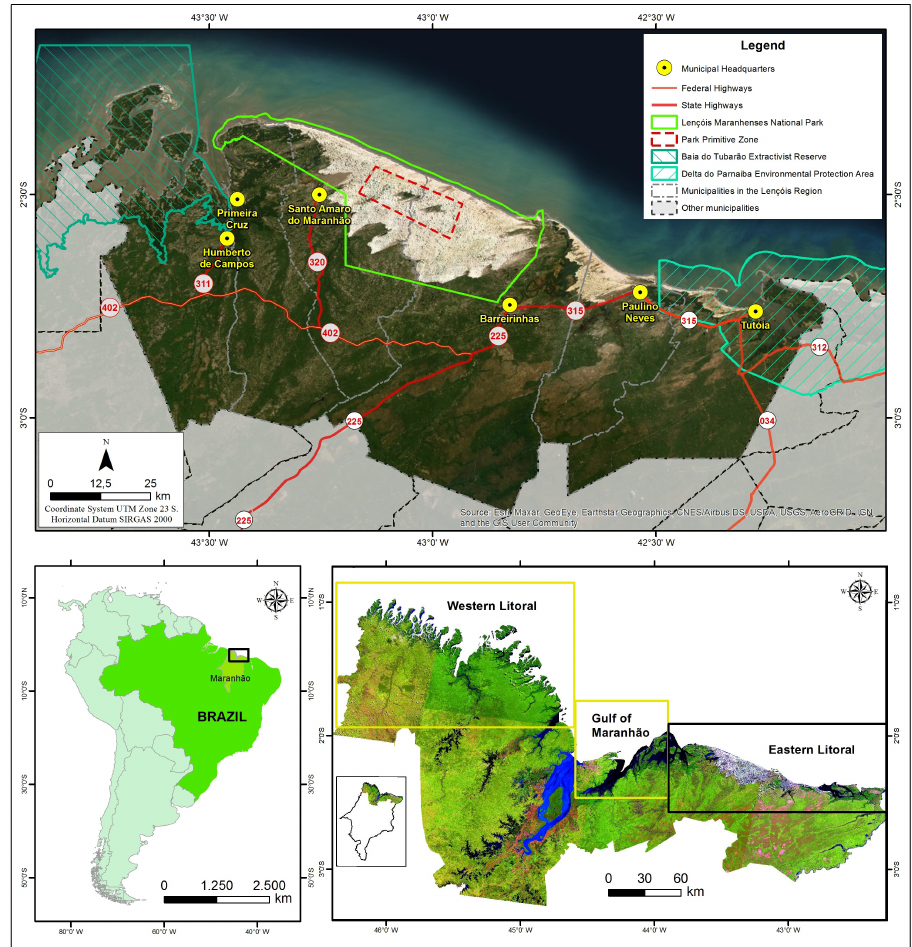
Figure 2. Location of the Lenç ó is Maranhenses